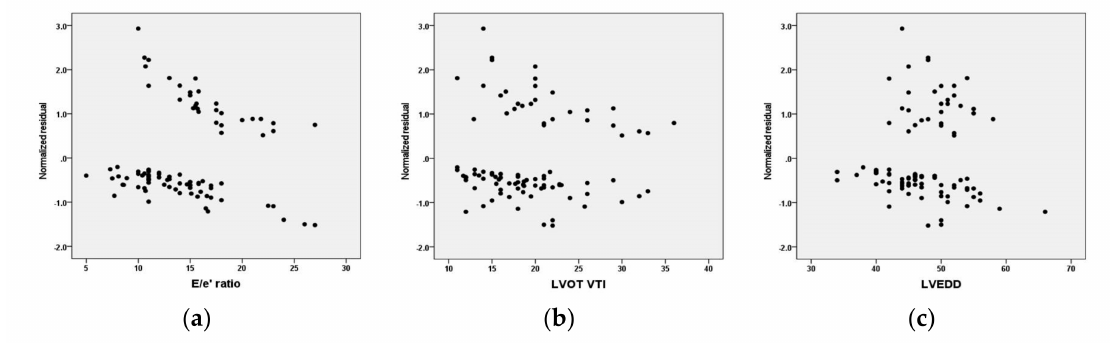
Figure 3. The normalized residuals for the model’s predictors: ( a ) E/e’ ratio, ( b ) LVOT VTI—left ventricular outflow tract velocity time integral, ( c ) LVEDD- left ventricle end-diastolic